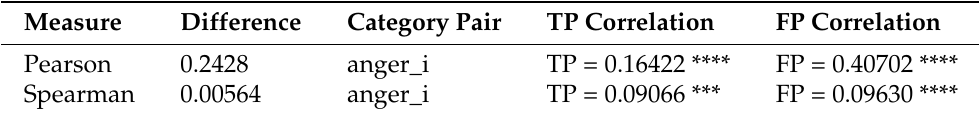
Table 30. Anger and 1st person pronoun in Medium.